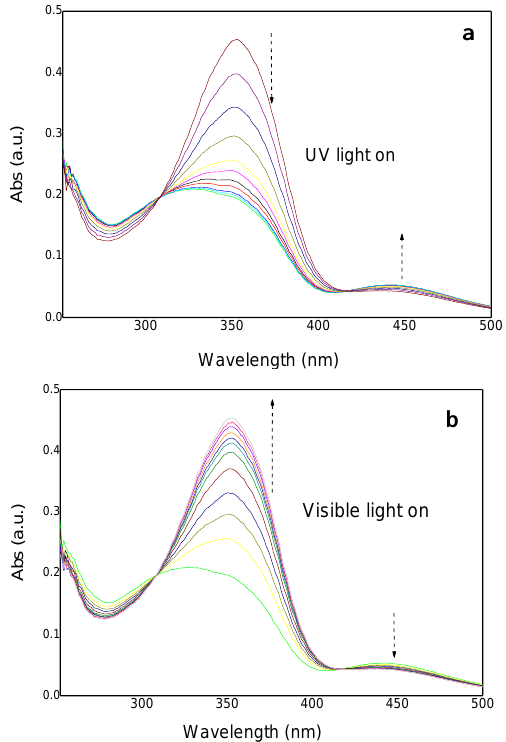
Figure 6. C4-Azo-C5-HDA in water (0.002 wt%, 20 °C). ( a ) Change in absorption of UV-Vis spectra over time under UV light (365 nm, 3.8 mW/cm 2 ), data were collected every 3 s; ( b ) change in absorption of UV-Vis spectra over time under visible light (12.1 mW/cm 2 ), data were collected every 10 s. C4-Azo-C5-HDA is also an amphiphilic surfactant, which can be used as an emulsi- fier. C4-Azo-C5-HDA dissolved in water and n-hexane solvent was added drop wise